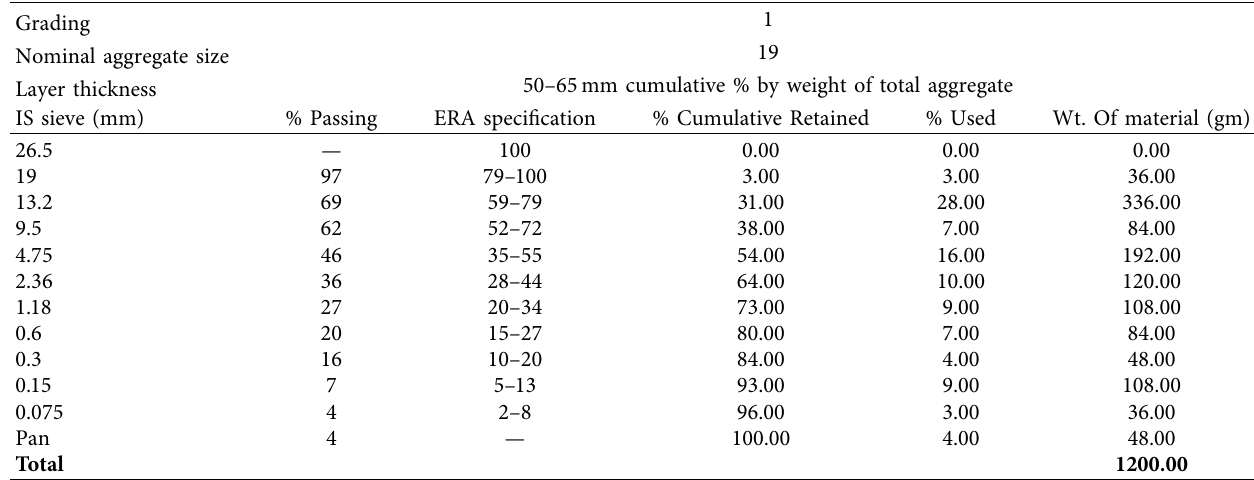
Table 1: Mix composition and sieve analysis of aggregates.